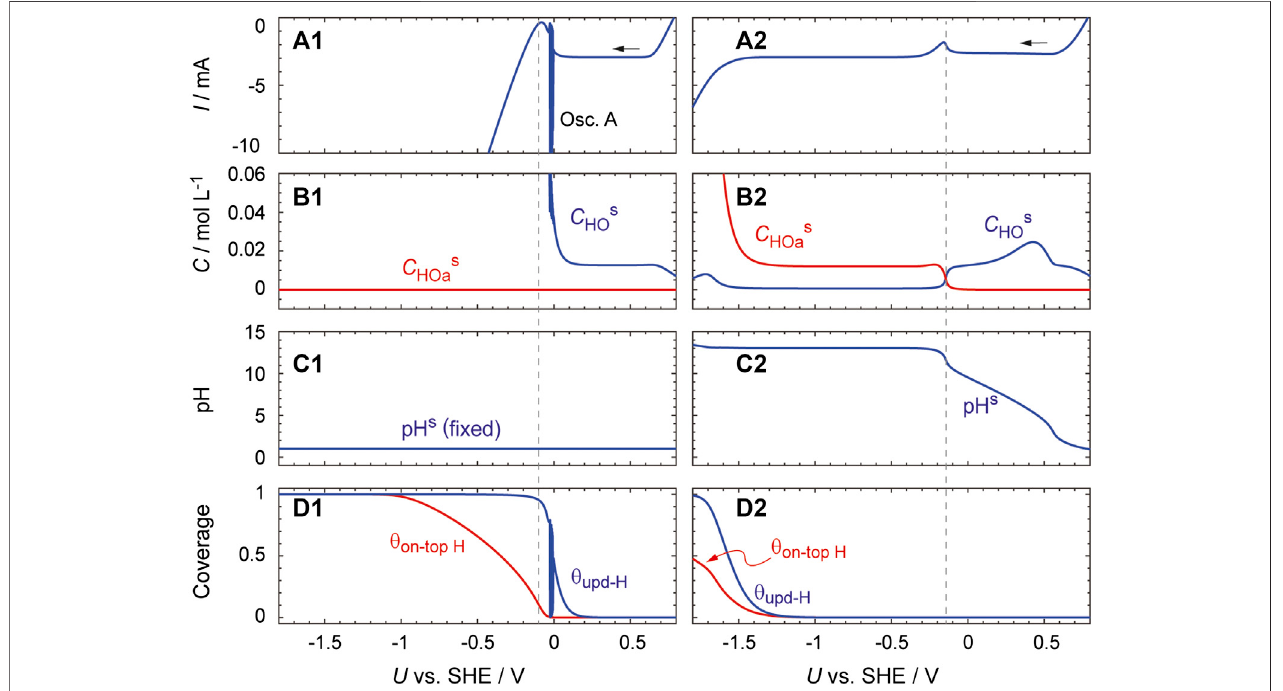
FIGURE8| Simulatedcurvesgeneratedwith U beingscannedatarateof0.01 V s − 1 from1.0 V.Theywereobtained (left) byperformingthecalculationwithd C H s /d t (cid:2) 0 and (right) by using Eqs. 17 and 18 to calculate d C Hs /d t . Parameter values used were: C Hb (cid:2) 1.0 × 10 – 4 mol cm − 3 , C HOb (cid:2) 3.1 × 10 – 4 mol cm − 3 , A (cid:2) 0.03 cm 2 , E 10 (cid:2) E − 10 (cid:2) 0.14 V, E 60 (cid:2) E − 190 (cid:2) 1.13 V, E 190 (cid:2) 0.84 V, E 200 (cid:2) E 210 (cid:2) 0 V, k 10 (cid:2) 1.0 × 10 – 2 cm s − 1 , k − 10 (cid:2) 1.0 × 10 – 5 mol cm − 2 s − 1 , k 50 (cid:2) k 5a0 (cid:2) 4.0 × 10 – 2 cm s − 1 , k 60 (cid:2) k − 190 (cid:2) 1.0 × 10 – 5 cm s − 1 , k 190 (cid:2) k 200 (cid:2) 1.2 × 10 – 1 cm s − 1 , k 210 (cid:2) 1.2 × 10 4 cm s − 1 , α 1 (cid:2) 0.3, α − 1 (cid:2) 0.7, α 6 (cid:2) 0.72, α i (cid:2) 0.5 ( i (cid:2) 19, − 19, 20, or 21). The other parameters (namely, δ , T , N 0 , R Ω , C DL , E 20 , E − 20 , k 20 , k − 20 , k 30 , α 2 , α − 2 ) were the same as those used for Figure 6 . The initial values of C Hs and C s are set at C Hb and C HOb , respectively. To remove errors at an initial stage, the data obtained at U ≤ 0.8 V are displayed.